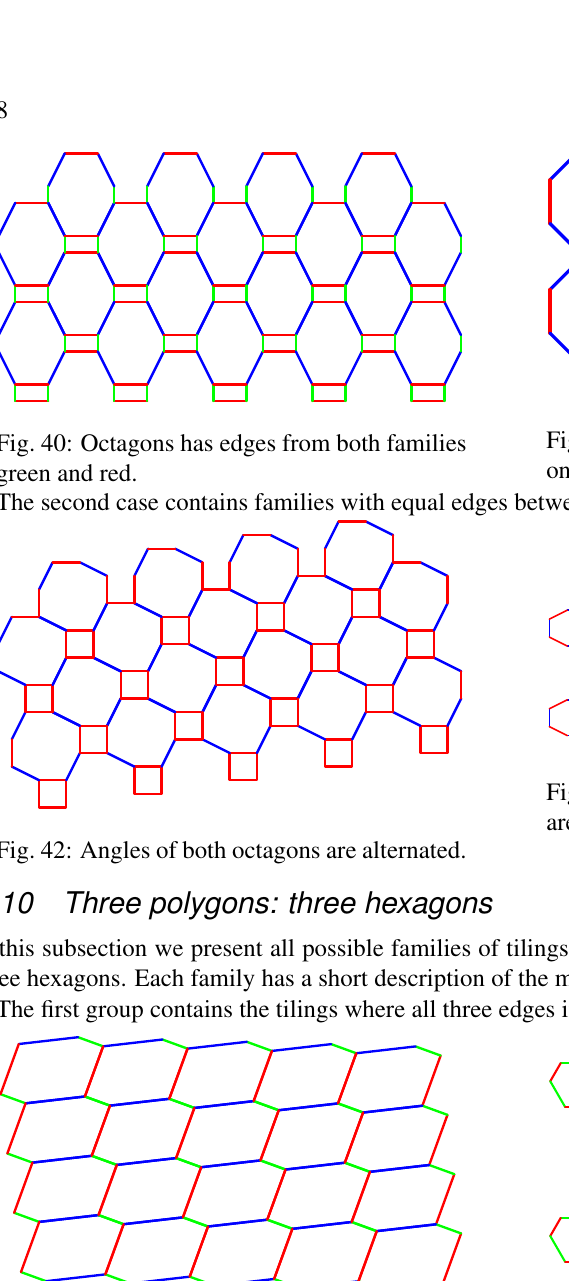
Fig. 45: All hexagons are different and have al- ternating